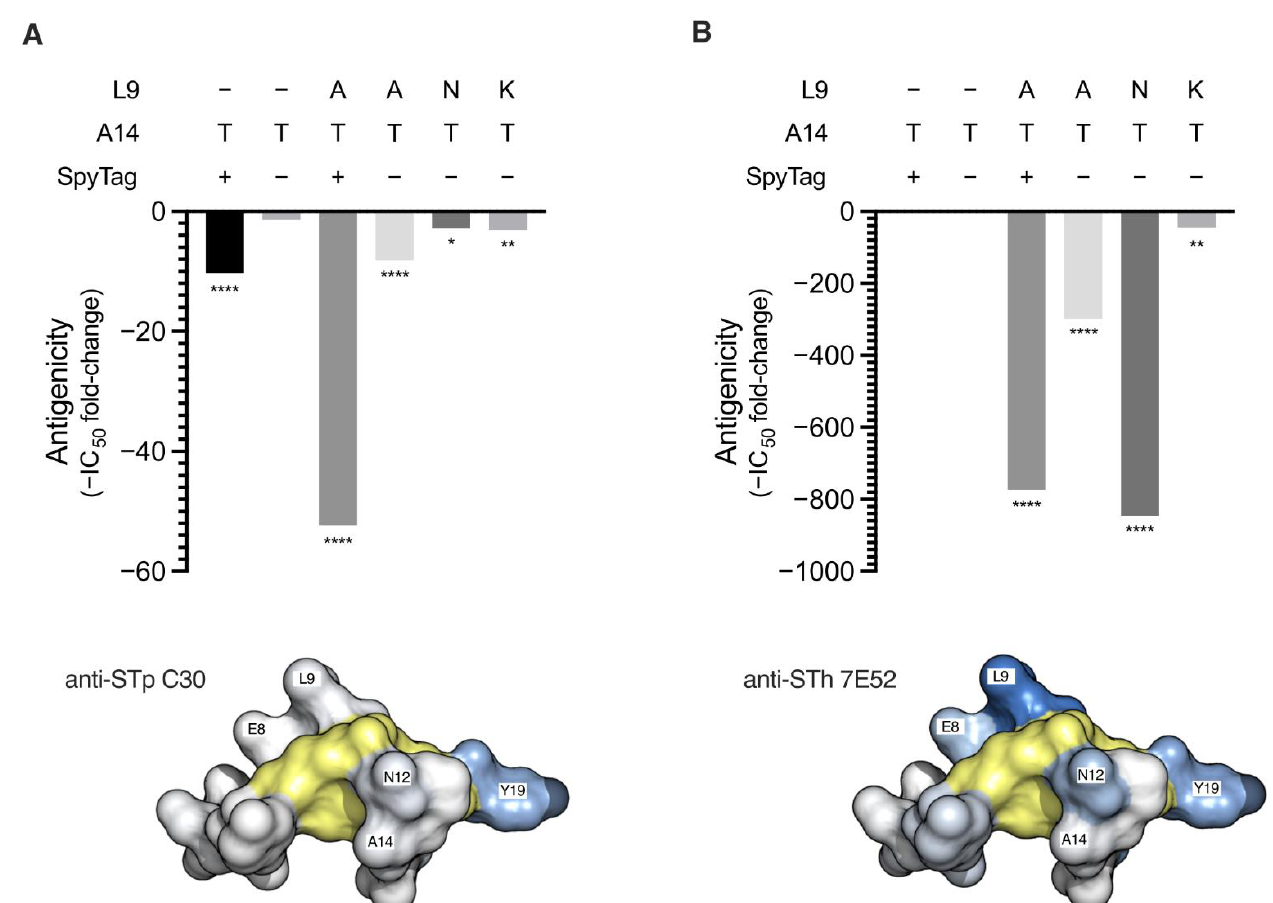
Figure 1. Antigenicity of STh mutant peptides. The antigenicity of the STh mutant peptides towards the anti-STp C30 ( A ) and anti-STh 7E52 ( B ) mAbs were tested using competitive ELISAs. Mutations carried by the STh mutant peptides and the presence of an N-terminal SpyTag are indicated above the plots. The ELISA plates were coated with native STh peptide, and free native STh (control) or the indicated mutant peptides were used to compete for binding to the coating. The 50% inhibitory concentration (IC 50 ) for all peptides were estimated using four-parameter logistic regression analyses, and the bar graphs show the IC 50 fold-changes of all mutant peptides relative to that of native STh. The fold-changes are plotted as negative values to indicate reduced antigenicity. To test whether the IC 50 for a given mutant peptide was significantly different from that of native STh, ordinary one-way ANOVA and Dunnett ’ s multiple comparisons test was performed. Significantly different IC 50 s are indicated below the bars: ****, p < 0.0001, **, p < 0.01, *, p < 0.1. Space-filling structural models are shown below the bar graphs to illustrate the location of the named main epitope residues for each mAb (shades of blue) [22,27]. The six cysteines forming the three-disulfide bridges are shown in yellow.